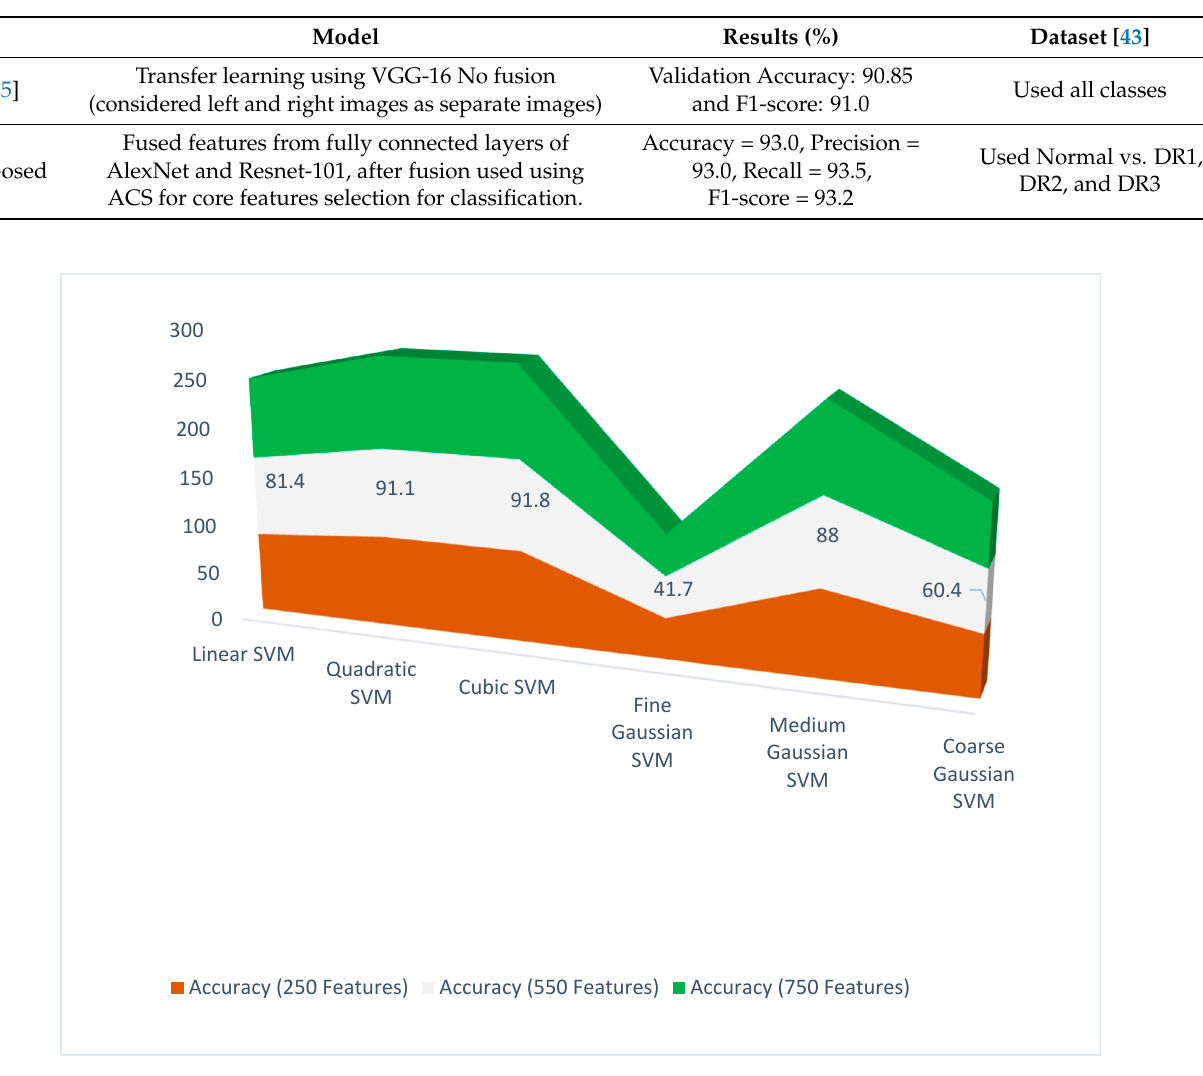
Figure 10. Assessment of accuracy based on features.